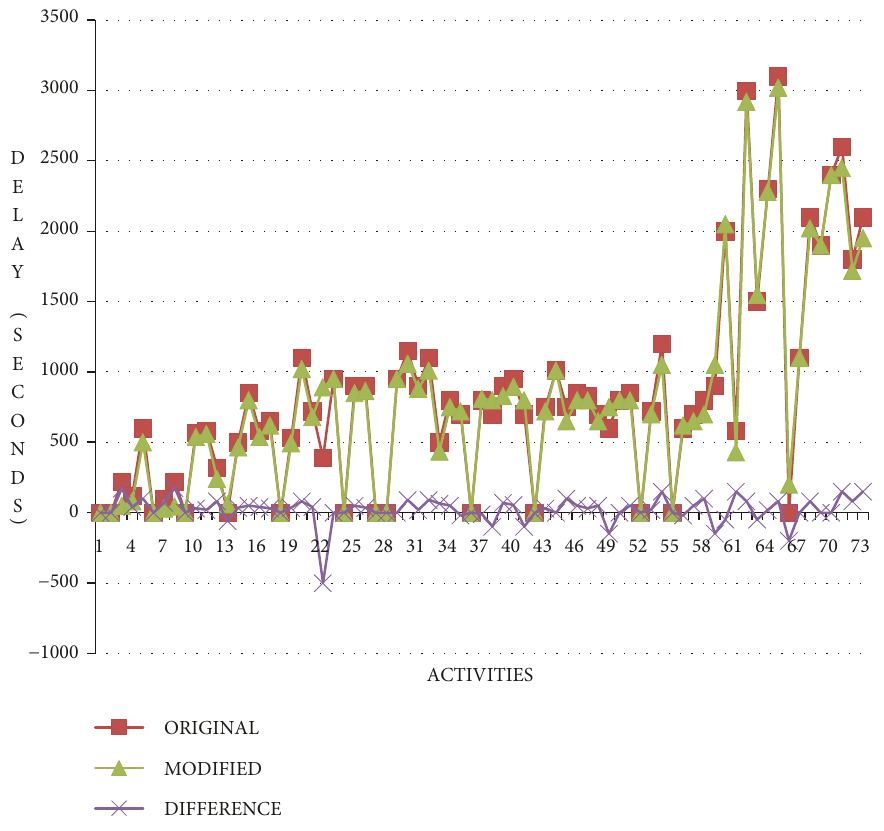
Figure 8: Delay absorption behavior of original and modified timetable for random delays at all segments.